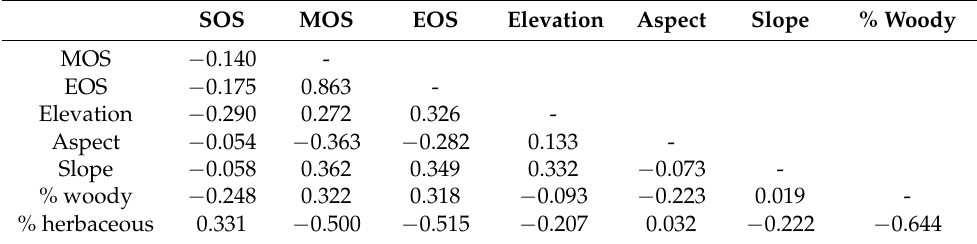
Table 8. Matrix of Spearman’s rank correlation coefficients of the phenological indices (SOS, MOS, EOS) and the environmental factors after normalization. n = 1,716,915 pixels per variable, including only areas of Mediterranean vegetation, as shown in Figure 13. The phenological indices were calculated for the time period between October 2018 and September 2019, using 62 cloud-free VEN µ S images. SOS MOS EOS Elevation Aspect Slope % Woody MOS − 0.140 −